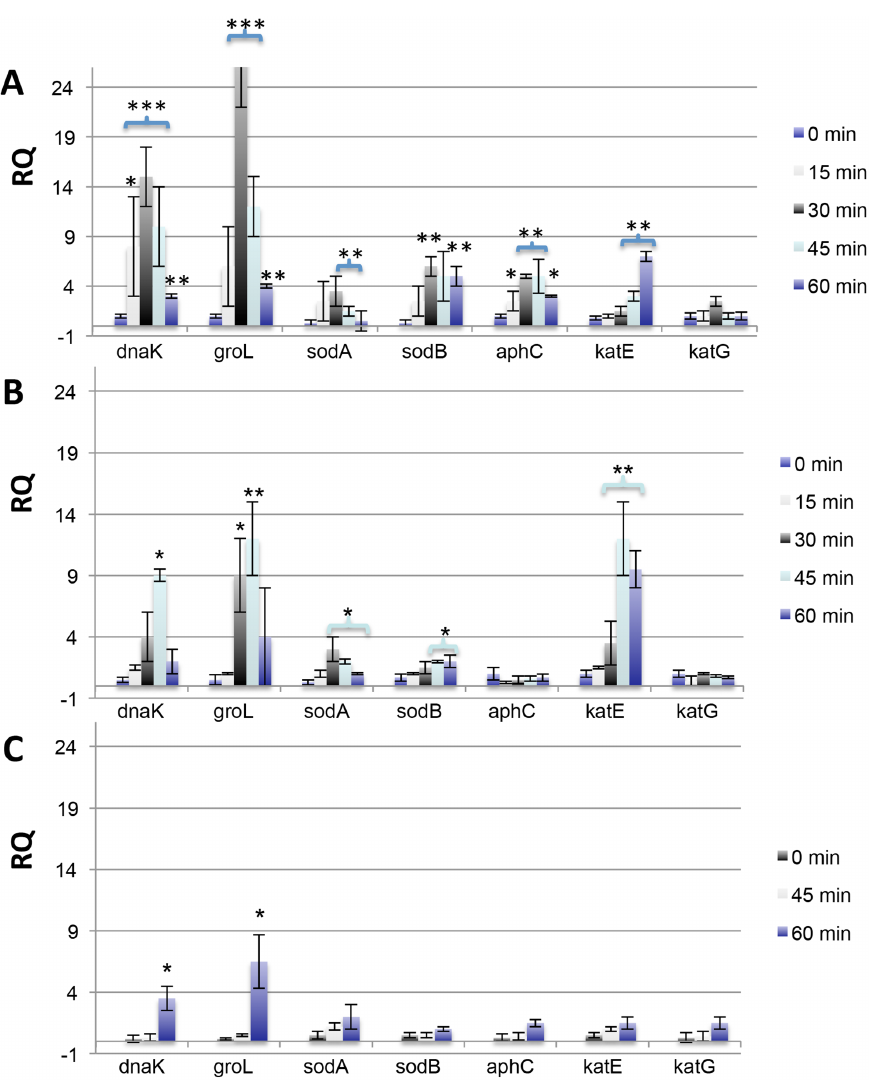
Figure 3. Time course of gene regulation for exposures to fosmidomycin, kanamycin, and tetracycline. Gene expression (in relative quantitation, or RQ, compared to untreated controls) is presented for cells challenged with the following antibiotic concentrations: a) fosmidomycin (20 m g/mL), b) kanamycin (2 m g/mL) and c) tetracycline (0.25 m g/mL). All experiments were performed on three independent replicates and errors presented as the standard error of the mean (*=p , 0.05, **=p , 0.01, ***=p ,